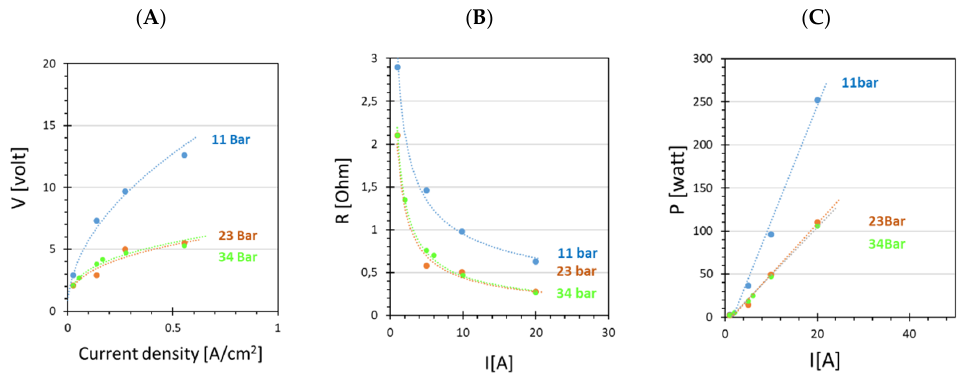
Figure 8. Polarization curve ( A ); resistance of electrolyzer ( B ) and electric power ( C ) as a function of current for the Ir-Pt-Nafion™ 117 CCM at three different clamping pressures. The increase in clamping pressure from 11 to 23 bar caused also a very small increase